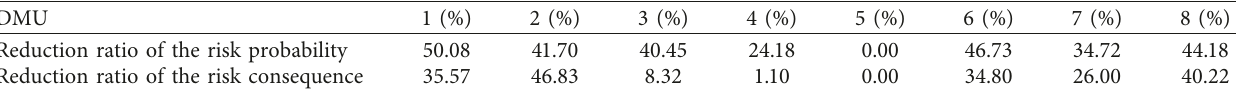
Table 6: Reduction ratio of risk